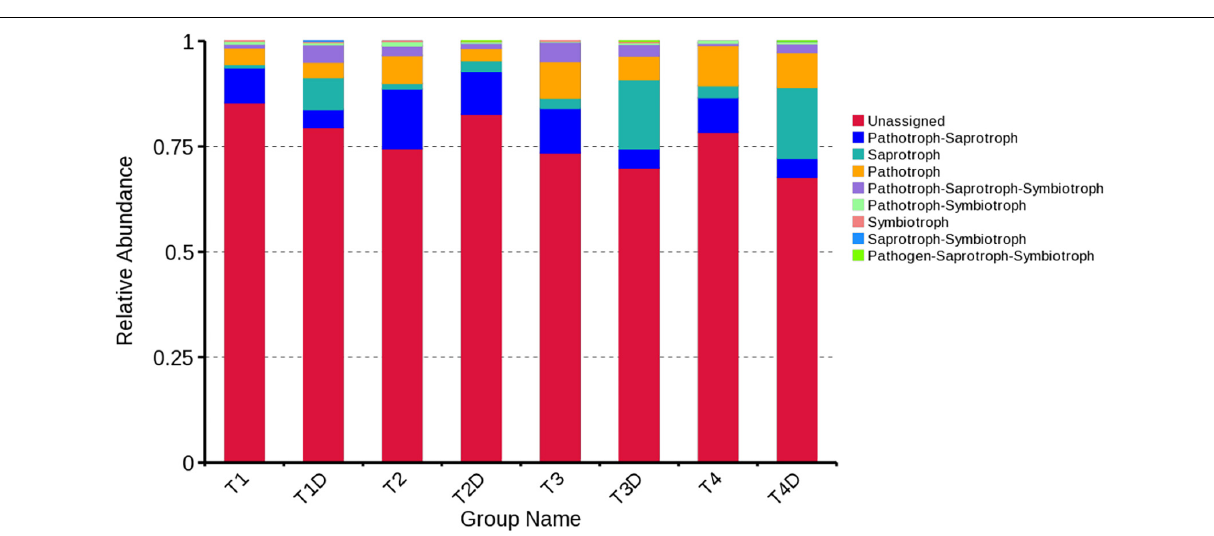
FIGURE 6 | Principal Co-ordinate Analysis (PCoA) analysis of the fungal (A) and bacterial (B) communities in the different group samples.